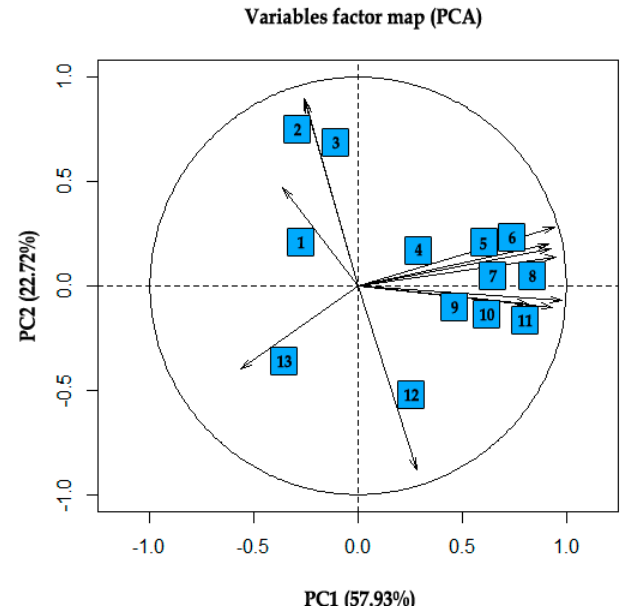
Figure 5. PCA of shape factors: 1—Malinowska factor 2—aspect ratio (AR), 3—Feret factor, 4—Feret diameter X, 5—height, 6—width, 7—W2_circumference 2, 8—perimeter, 9—W1_circumference 1, 10—Feret diameter Y, 11—Area,12—Round, 13—Solidity [10,46].